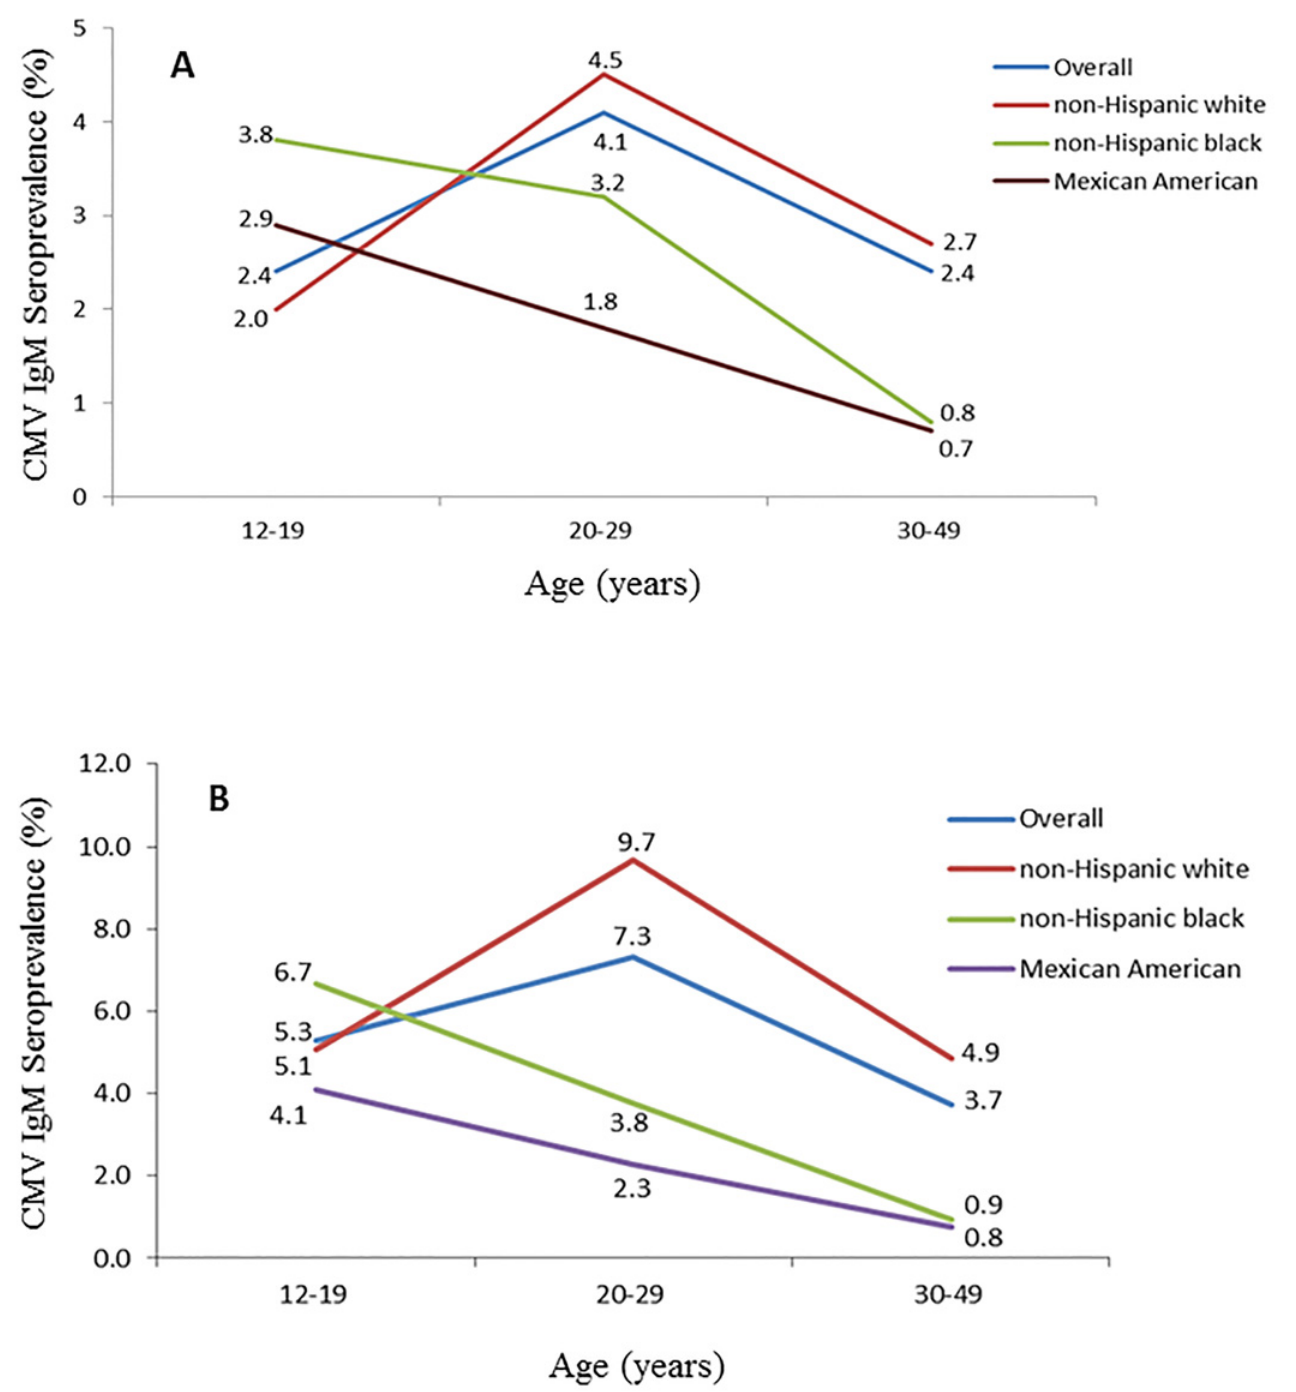
Fig 1. Cytomegalovirus IgM seroprevalence among All Women (Panel A) and IgG+ Women only (Panel B) by Age and Racial/ethnic Group, NHANES III, 1988 –